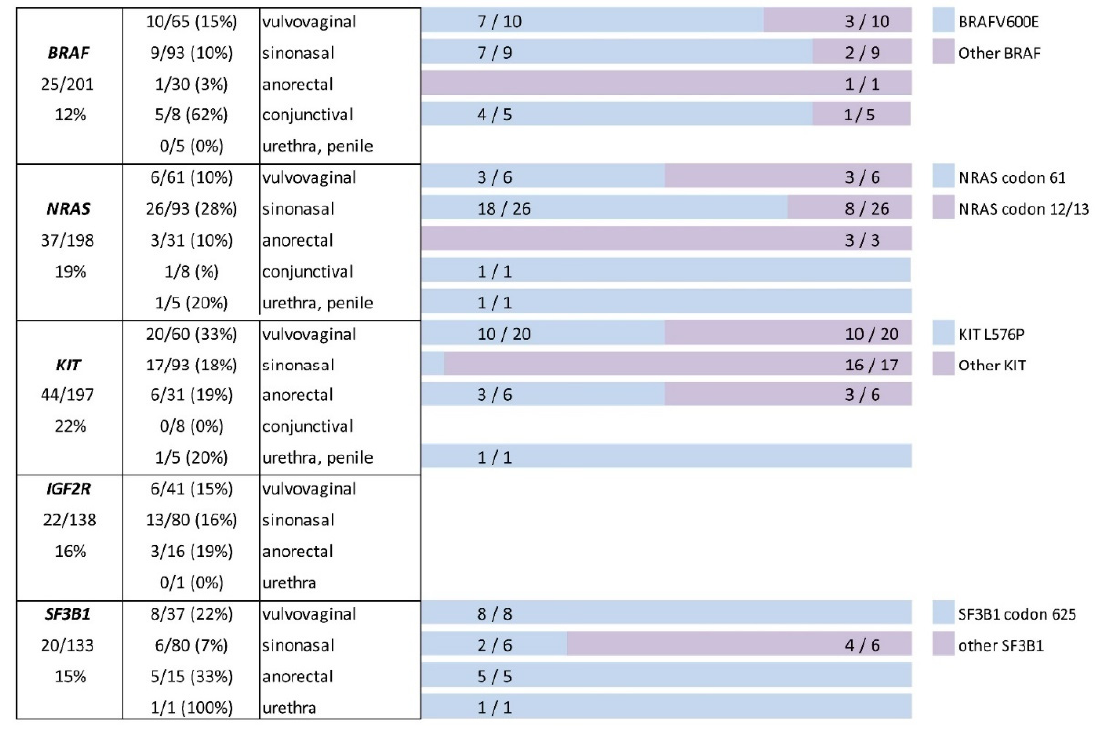
Figure 2. Summary of the molecular analyses. BRAF V600E, NRAS codon 61, KIT L576P and SF3B1 codon 625 are the most frequently detected mutations.